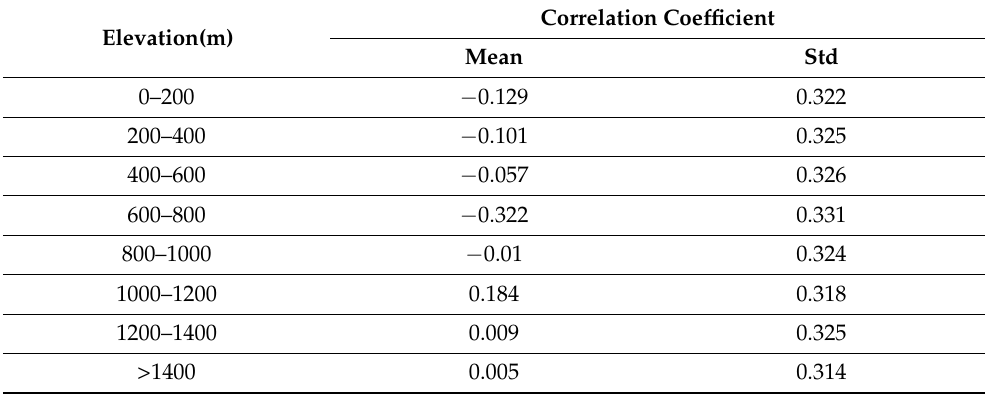
Table 2. Correlation coefficient of vegetation greenness and land surface temperature by